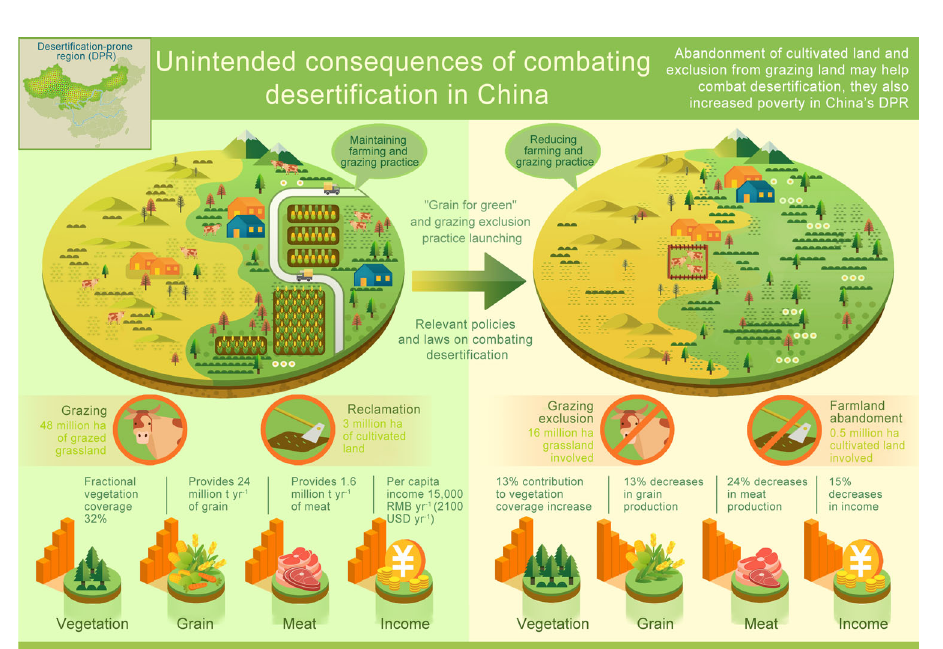
Fig. 5 | Impacts of the “ grain-for-green ” and grazing exclusion practices in the deserti fi cation-prone region. At present, 3.2 million and 48.3 million hectares of land are used for farming and grazing in the deserti fi cation-prone region, respec- tively. These available farmland and grassland provided 24 million tonnes of grain and 1.6 million tonnes of meat in 2020 (Supplementary Fig. 7) and generated